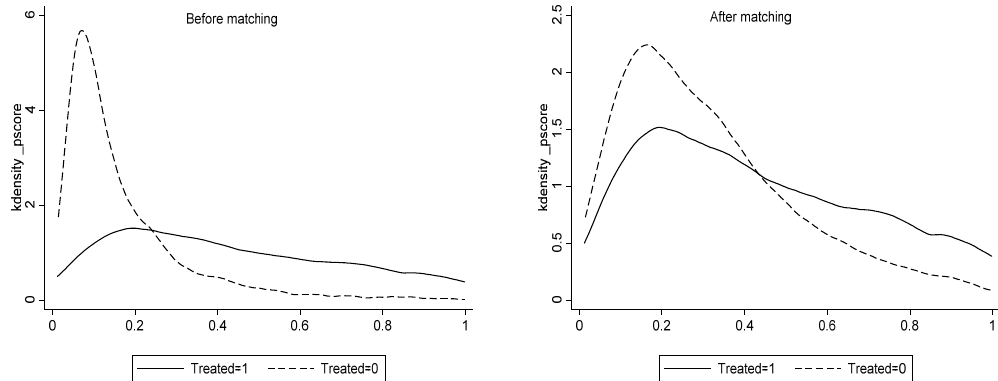
Figure 4. Kernel distribution of the propensity scores before and after matching. Table 5. Reduced bias in the covariates after matching.